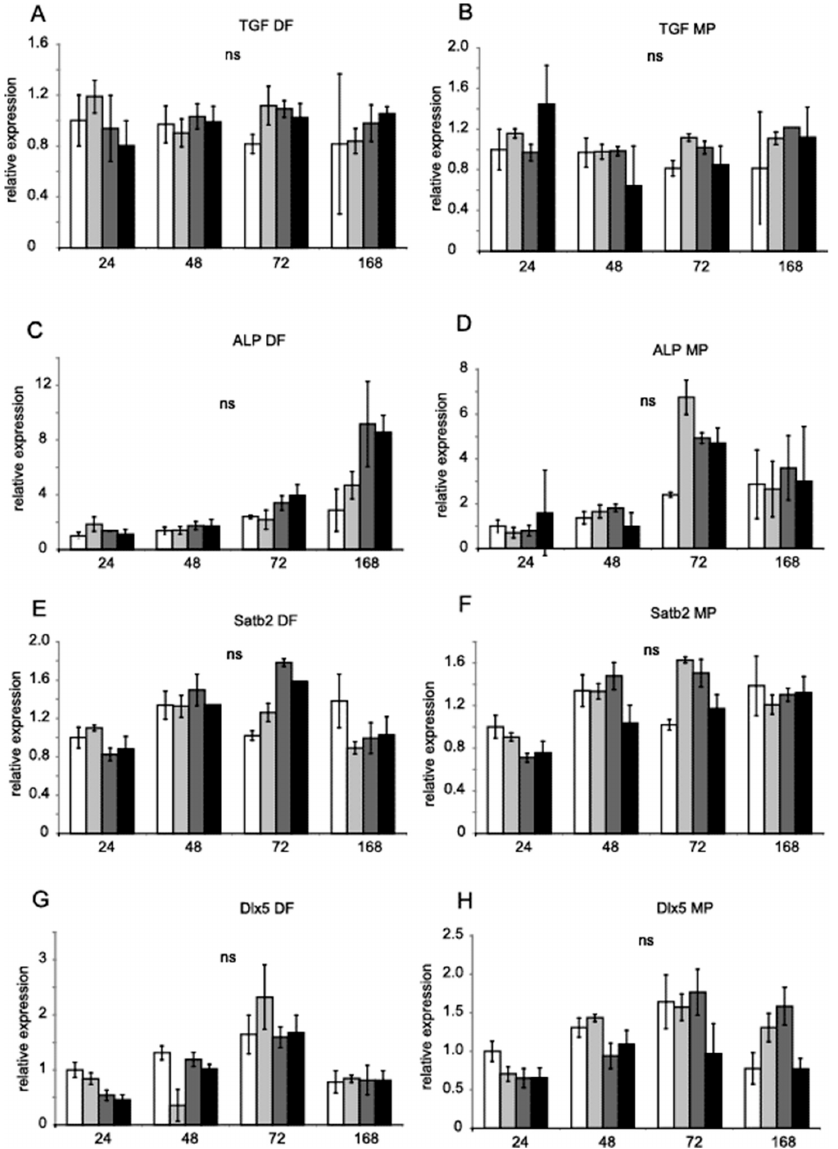
Figure 4. Gene expression in MC3T3-E1 in the presence of DF and MP . Tgfb1 , Alp , Satb2 , and Dlx5 mRNA levels in MC3T3-E1 cells treated with DF ( A , C , E , G ) 0.5 µM, 5 µM, 50 µM (increasing grey scale, respectively) for 24 h, 48 h, 72 h, and 168 h. MC3T3-E1 cells were treated with MP ( B , D , F , H ) 0.5 µM, 5 µM, 50 µM (increasing grey scale, respectively) for 24 h, 48 h, 72 h, and 168 h. Untreated control equals 1 (open bars). Results are presented as geometric means of relative expression. Hprt and B2m were used as reference genes. The significance was evaluated using one-way ANOVA with Tukey’s post hoc test. The significance level was set at 5% ( p < 0.05). Error bars represent ±